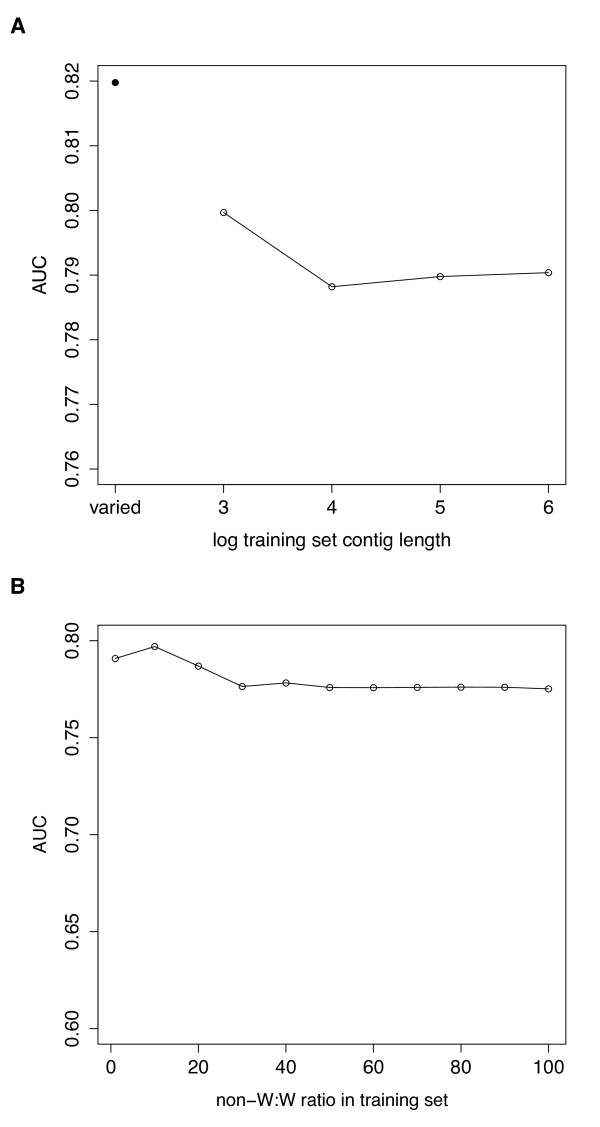
Performance of the classifier as a function of contig length and training set composition. Here the validation set consists of the confirmed chrUn contigs, and the training set is a subset of the set of mapped contigs. (A) Contig length matters. The open circles show results without conditioning on length; instead, the same validation set was classified using training sets with different contig lengths (1 kb - 1000 kb). For each contig length, we randomly selected 200 W & 200 non-W contigs for the training set. This was performed 100 times. The validation set contigs are short (average <1 kb in length), and the classifier performs better when shorter contigs are used for training. However, performance is maximized when we condition on length in the classifier (solid circle). Classifier performance is measured by mean AUC. (B) AUC for different ratios of non-W to W contigs in the training set. AUC increases for smaller non-W:W ratios.